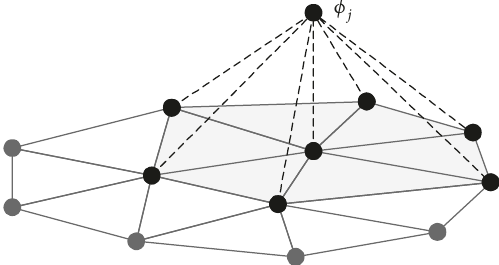
Figure 2: Example of the Finite Element basis